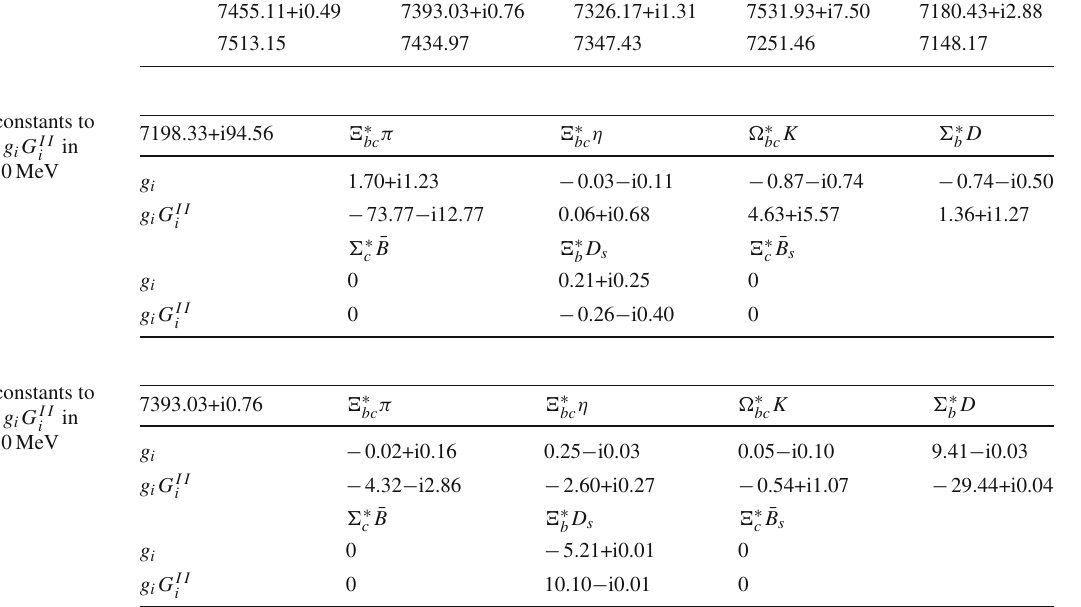
Table 31 Poles for pesudoscalar-baryon (3/2) (S) states (all units are in MeV)